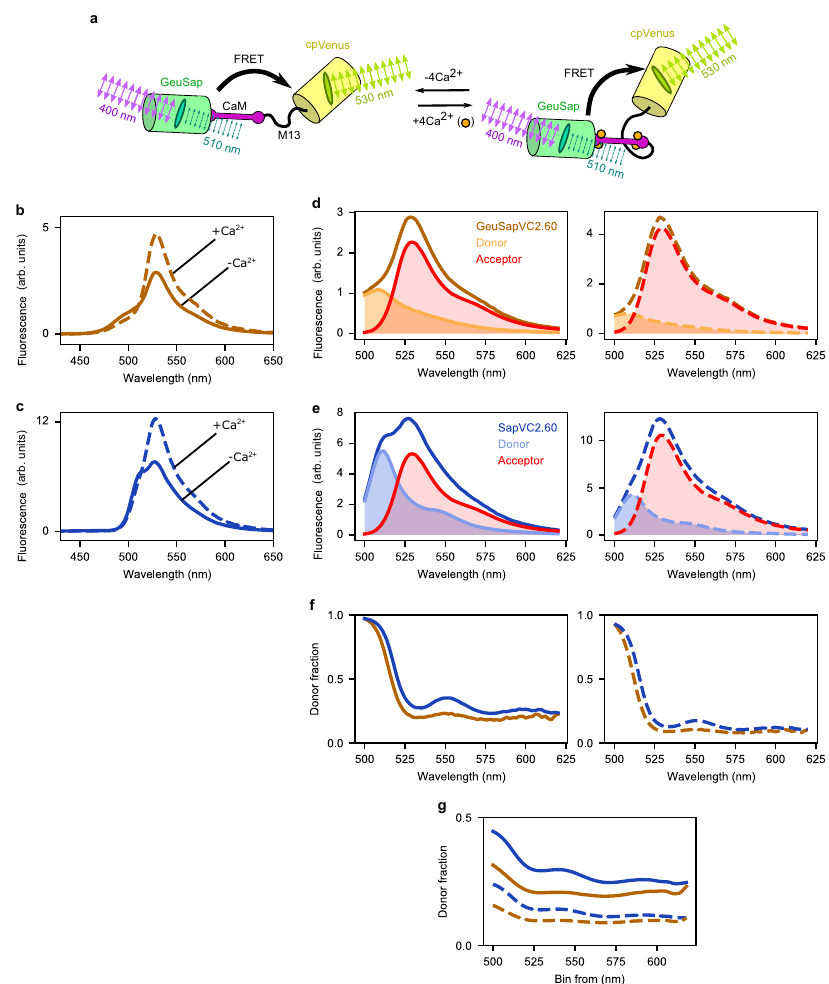
Fig. 4 Spectral properties of GeuSapVC2.60. a Cartoon representation of GeuSapVC2.60 in its Ca 2 + -free and -bound form under polarized illumination. b , c Emission spectra of GeuSapVC2.60 ( b ) and SapVC2.60 ( c ), under zero (solid line) and saturated (dashed line) Ca 2 + conditions. d , e Linear unmixing of donor and acceptor contributions in emission spectra of GeuSapVC2.60 ( d ) and SapVC2.60 ( e ), Ca 2 + -free (left) and Ca 2 + -bound form (right). f Donor fraction (of total signal) plotted based on the linear unmixing of GeuSapVC2.60 (orange) and SapVC2.60 (blue), Ca 2 + -free (left) and Ca 2 + -bound (right) forms. g Fraction of donor signal over total cumulative distribution of GeuSapVC2.60 (orange) and SapVC2.60 (blue) for Ca 2 + -free (solid lines) and Ca 2 + -bound conditions (dashed lines). Source data are provided as a Source Data fi